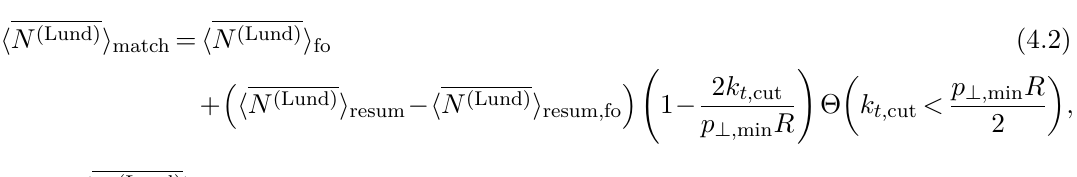
& p k R/ 2 = 300 GeV, well beyond the regime of validity of the resummed t, cut ⊥ , min